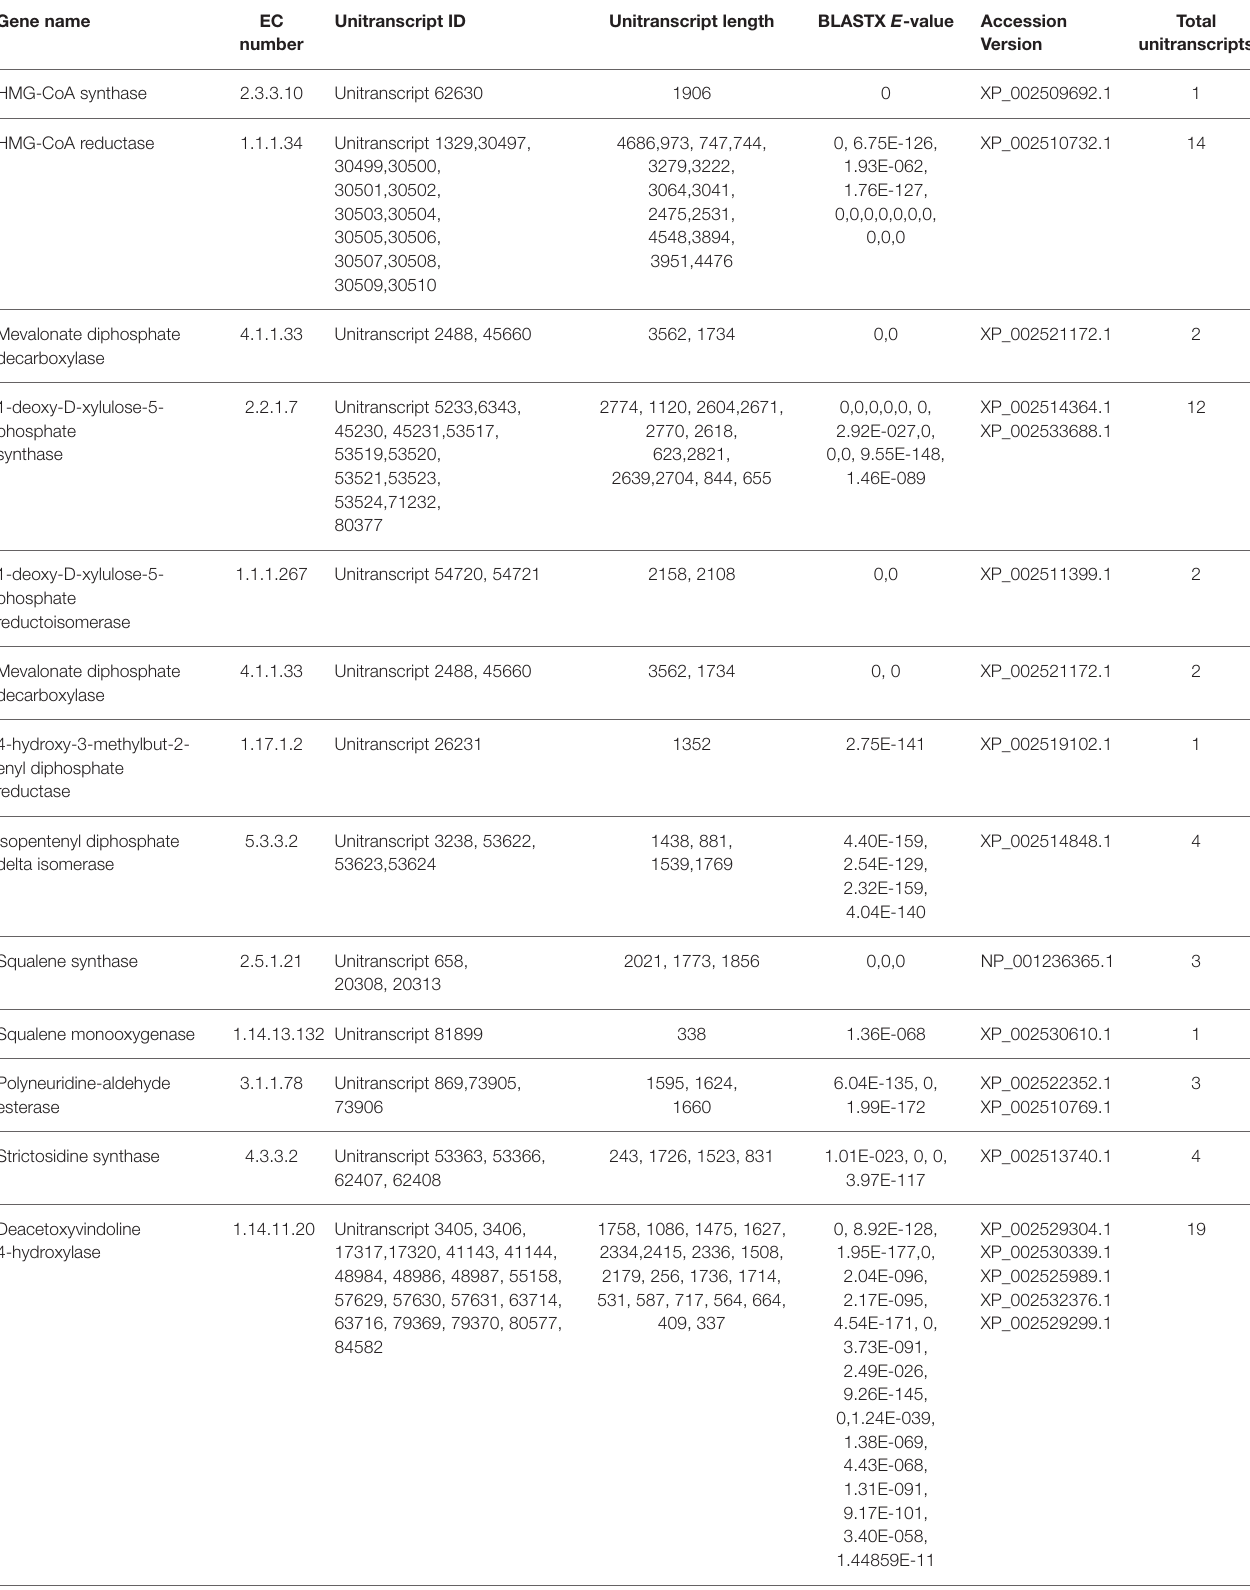
TABLE 2 | Summary of few major genes involved in Terpenoid and Alkaloid biosynthesis pathways identified putatively from P. amarus leaf